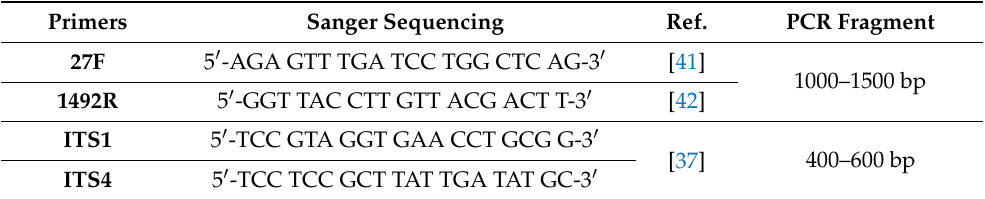
Table 2. Set of primers used for species identification PCR primers used for Sanger sequencing to identify cultivable microorganisms (bacteria: 27F/1492R; fungi: ITS1/ITS4).